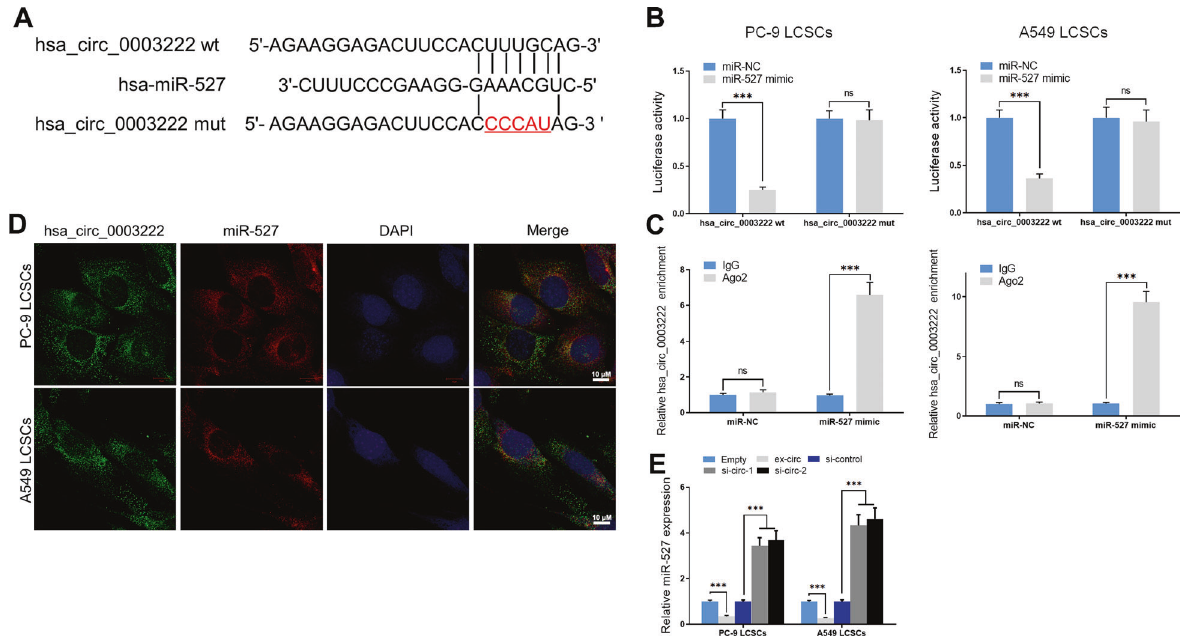
Fig. 3 hsa_circ_0003222 sponged miR-527 in PC9 and A549 lung cancer stem cells (LCSCs). A The predicted binding sites of miR-527 in the hsa_circ_0003222. The mutated (Mut) version of hsa_circ_0003222 is presented. B Relative luciferase activity was examed 48 h after transfection with miR-527 mimic/normal control (NC) or with the hsa_circ_0003222 wild-type/Mut in PC9 and A549 LCSCs. C Anti-AGO2 RIP was displayed in PC9 and A549 LCSCs, followed by RT-PCR to access hsa_circ_0003222. D FISH assays were performed to evaluate hsa_circ_0003222 and miR-527 location. E RT-qPCR demonstrating miR-527 level in LCSCs. Data were presented as mean ± SD; *** P < inhibition of hsa_circ_0003222 resulted in a tumor volume minor than control ( P < 0.01) (Fig. 6A, B). Representative HE staining in xenograft tumor tissue (Fig. 6C), immunohistochemistry of Ki-67 (Fig. 6D), and a TUNEL assay (Fig. 6E) all indicate that in xenograft tumor tissue, cell proliferation is increased when miR-527 is inhibited and apoptosis is increased when hsa_circ_0003222 is inhibited. The levels of hsa_circ_0003222 and PHF21B are meaningfully increased in tumor tissue when miR-527 is inhibited (Fig. 6F – H). The levels of stem cell-associated proteins measured in tumor tissue by western blotting and immuno fl uorescence were reduced by hsa_circ_0003222 inhibition but elevated by miR-527 inhibition (Fig. 6I, J). Orthotopic models of tumors were also reproduced in nude mice in the different treatments (Fig. 6K, L). Live imaging shows that hsa_circ_0003222 inhibition prevents